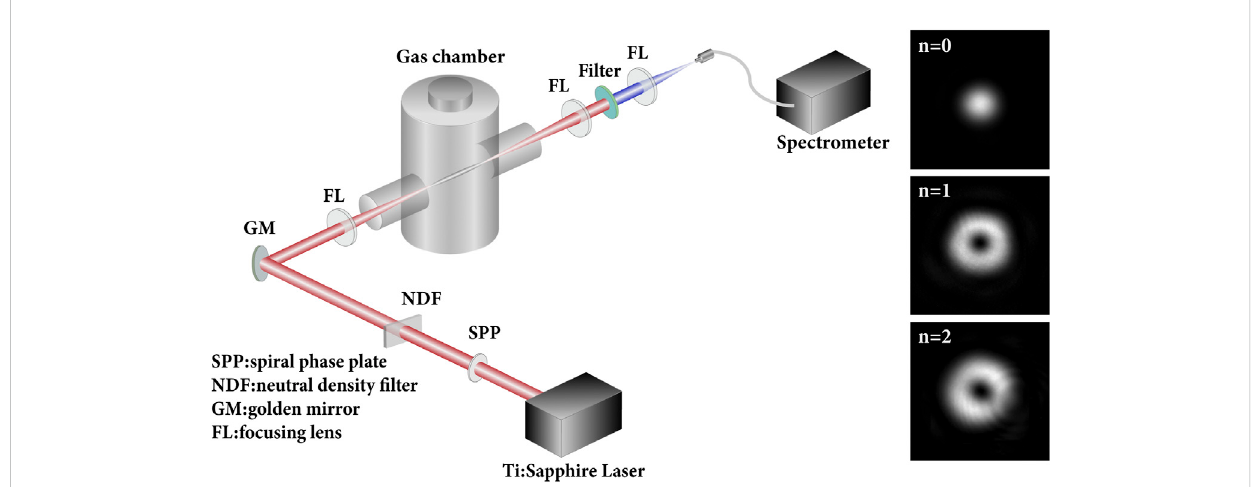
FIGURE 1 (Left panel) Schematic experimental setup. SSP: Spiral phase plate; NDF: neutral density fi lter; GM: golden mirror; FL: focusing lens; CCD: charged coupled device. (Right panel) Vortex beam pro fi le measured by CCD when TCs are 0 ( i.e. , Gaussian beam),1 and 2 with the same incident pulse energy.